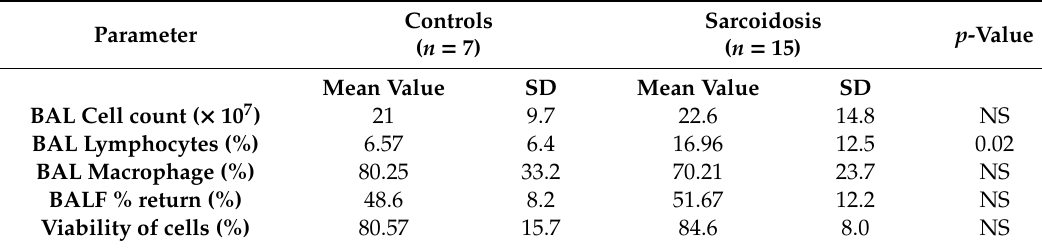
Table 2. Bronchoalveolar Lavage Cell